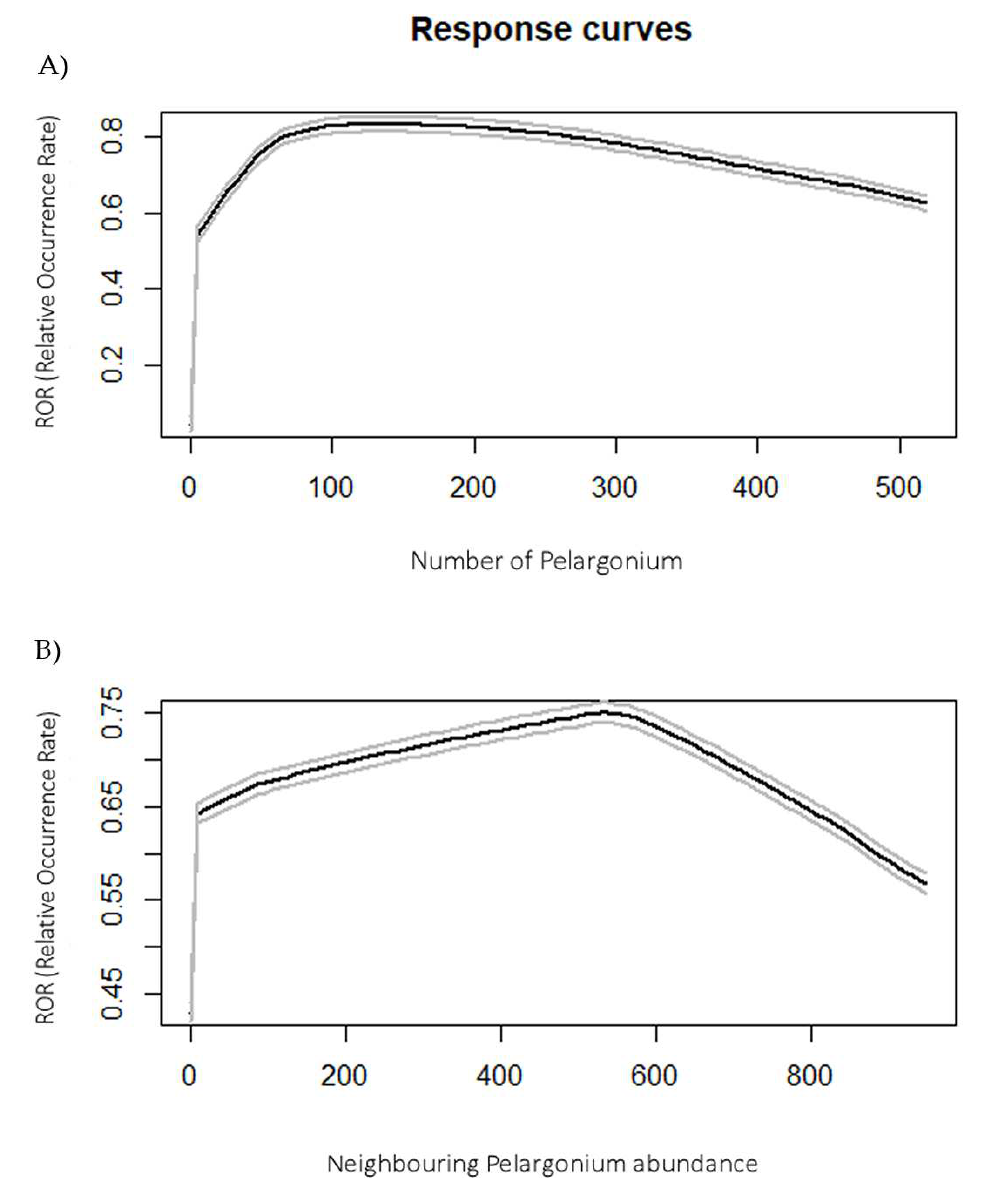
Figure 2. The graphs show the response curves (black lines) obtained with the MaxEnt model, including the confidence intervals (grey lines). ( A ) Along the x-axis: the number of Pelargonium plants; along the y-axis: the relative occurrence rate (ROR). ( B ) Along the x-axis: the number of Pelargonium plants in the neighbouring cells; along the y-axis: the ROR.